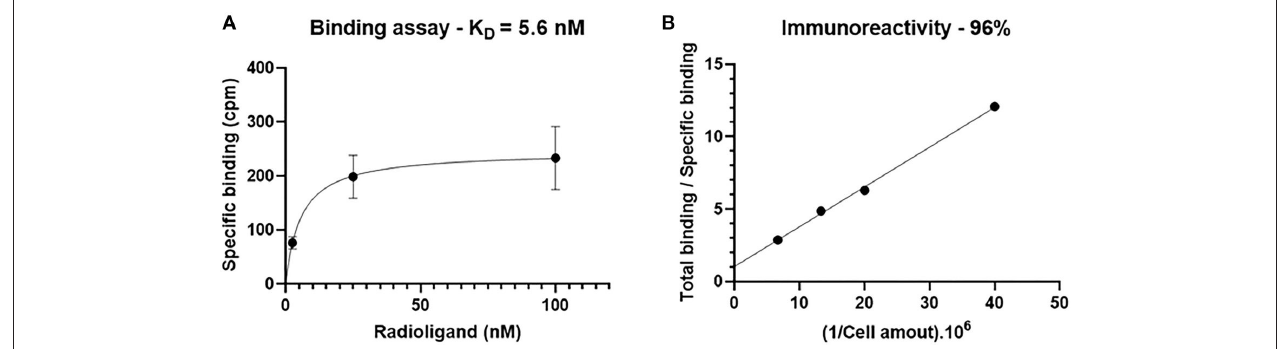
FIGURE 1 | Binding and immunoreactivity assays. (A) Binding assay was performed by subtracting total binding and non-specific binding by using constant cell concentration and increasing [ 89 Zr]DFO-anti-PDL1 concentration, Kd = 5.6nM. Error bars represent standard errors. (B) Immunoreactivity was performed using